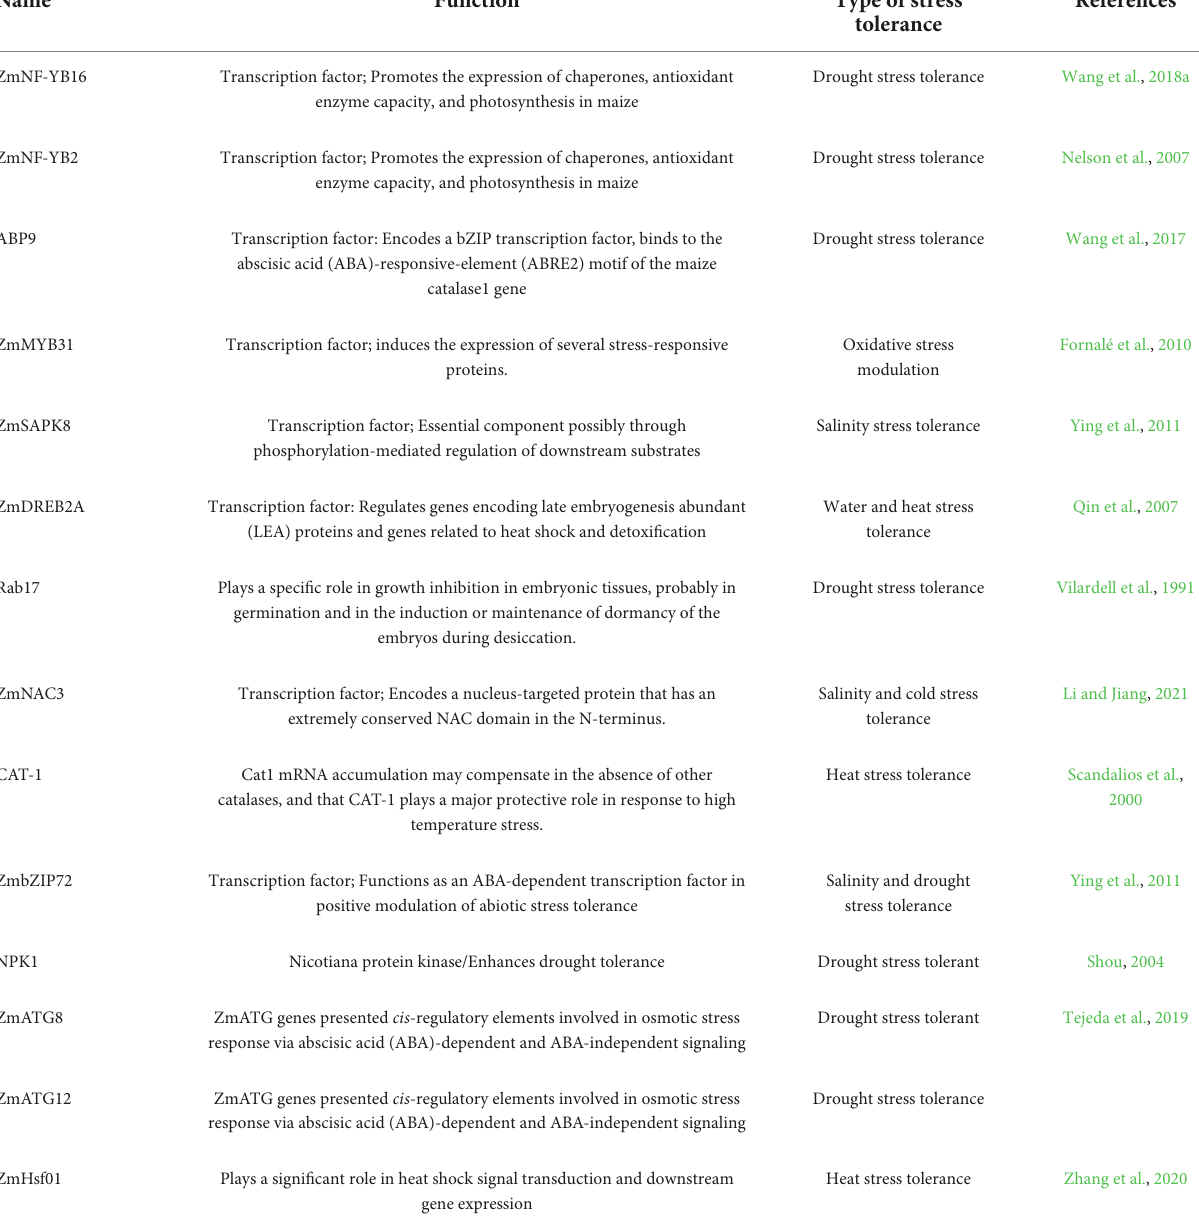
TABLE 1 Transcription factors and signal transduction genes associated with abiotic stress tolerance in